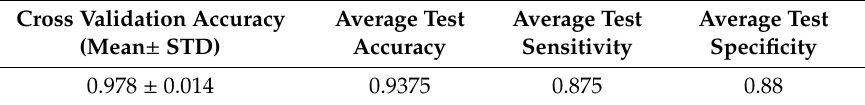
Table 3. Average accuracy, sensitivity, and specificity values of the proposed